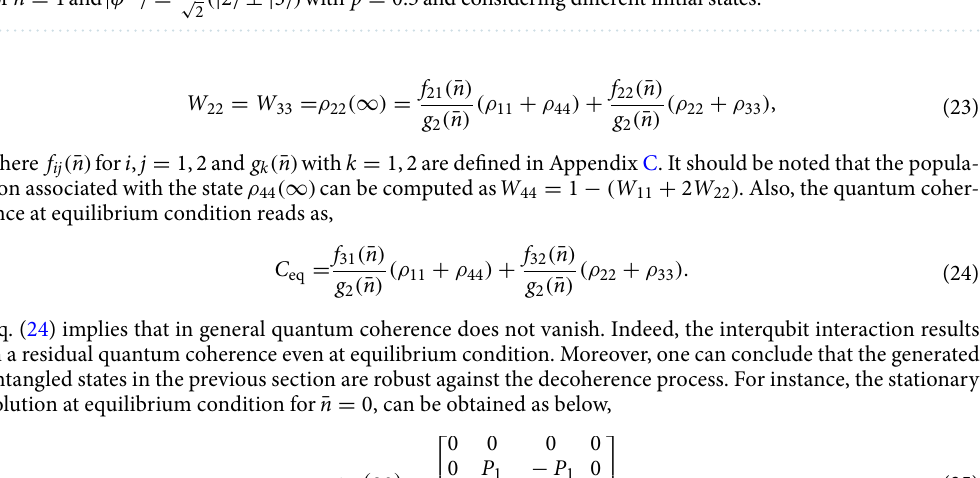
Figure 3. The population (diagonal elements) and coherence (nondiagonal elements) of the two-qubit system 1 1 and 0.5 and considering different initial 2 3 φ ± ( ) with p n for √ 2 ¯ = = | � = | � ± | �